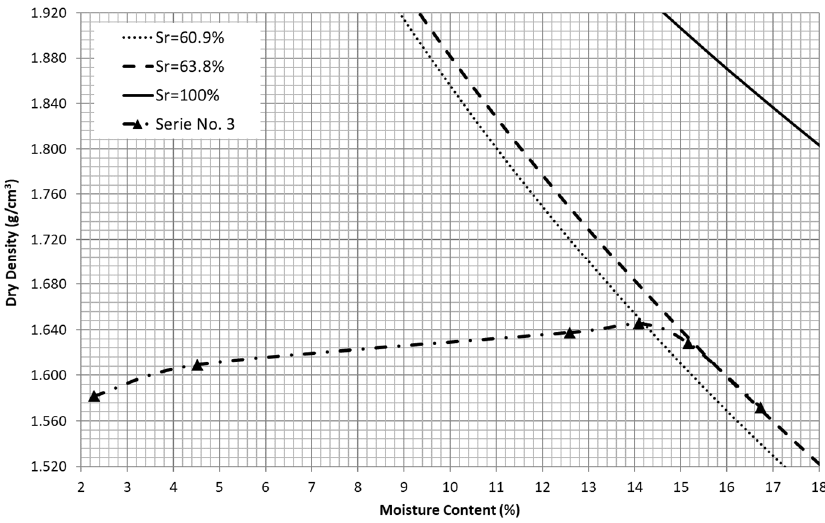
Figure 4. Compaction curve corresponding to series No. 3 and degree of saturation lines for optimum value (S r = 60.9%), for wet side (S r = 63.8%) and zero air void (S r = 100%).